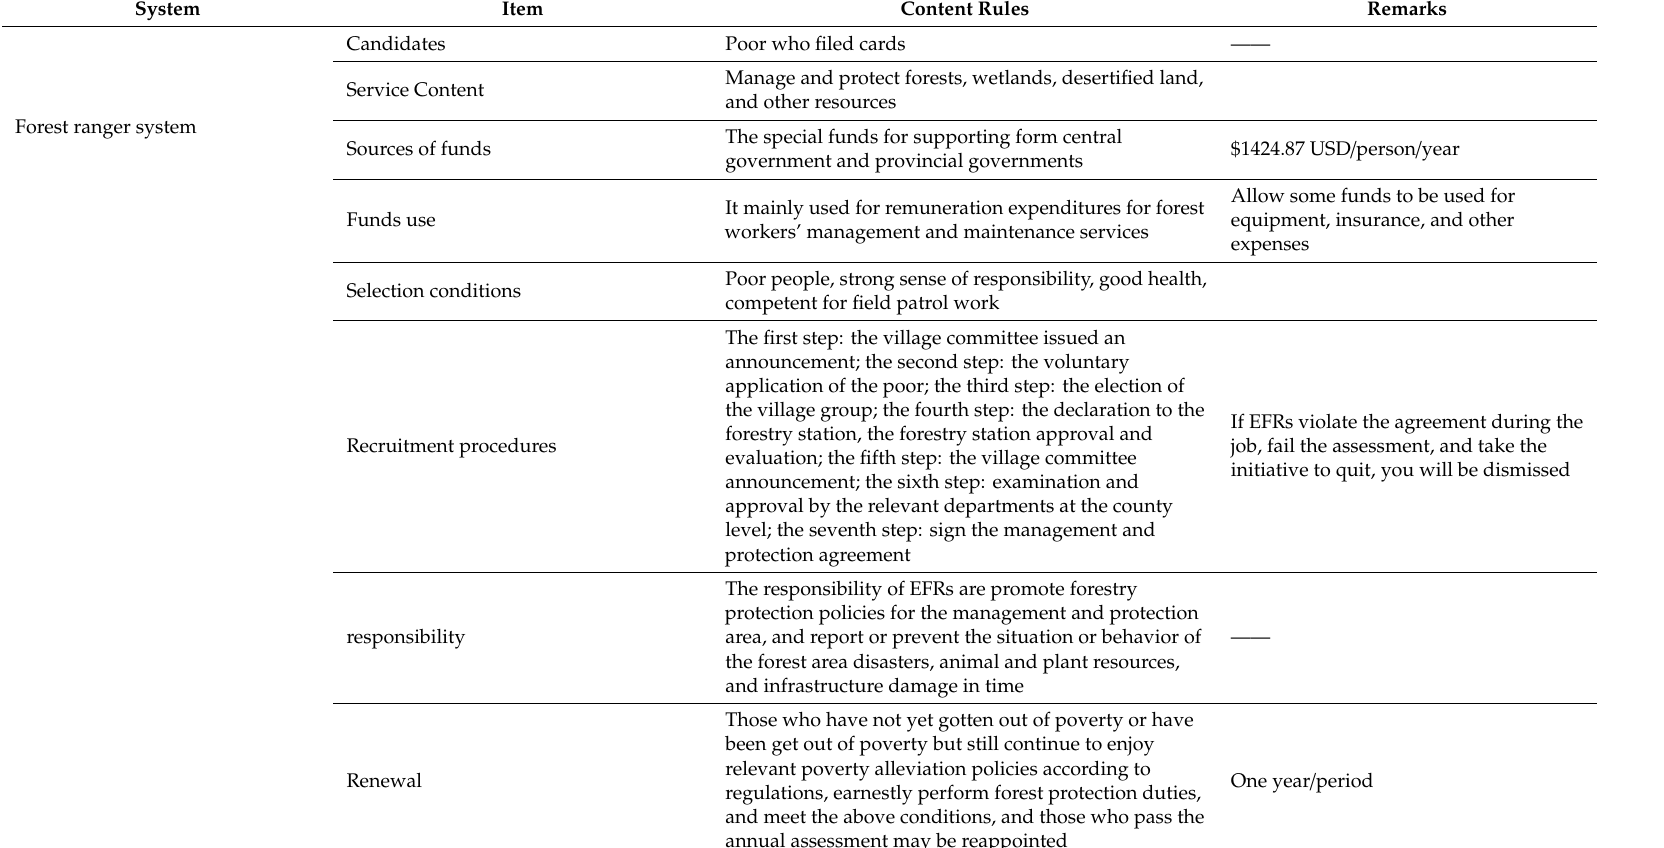
Table 1. Key content of the policy of ecological forest rangers for the poor (PEFRP)